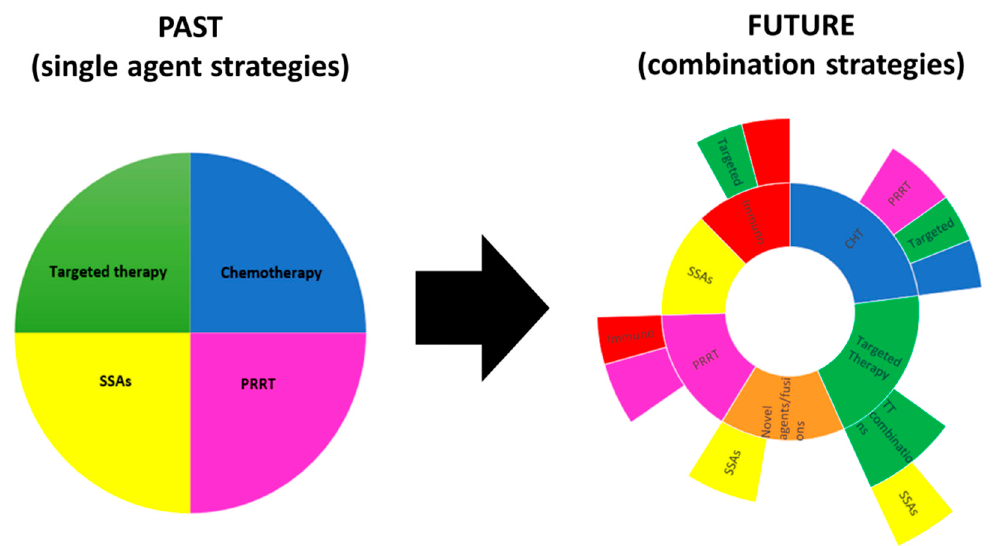
Figure 4. Comparison between previously used and currently explored treatment options. On the left you can see used before main therapeutic options focused on single treatment modality and on the right there is a graphic visualisation of currently explored treatment options expanding beyond monotherapies and exploring advantages of combining therapeutics with different mechanism of action. CHT—Chemotherapy; PRRT—Peptide receptor radionuclide therapy; SSAs—somatostatin analogues; IMT—immunotherapy; and, TT—targeted therapy.